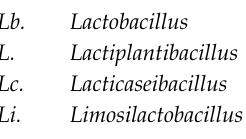
Table S1: microbial cell load (log CFU / mL) of Lactiplantibacillus plantarum c19 and c16, Lactobacillus acidophilus La5 and Bifidobacterium animalis subsp. lactis DSM 10140 attenuated through the combinations G, H, I and O (N = control), inoculated in vegetable beverages and stored at 4 ◦ C for 8 days. Data were expressed as mean ± standard